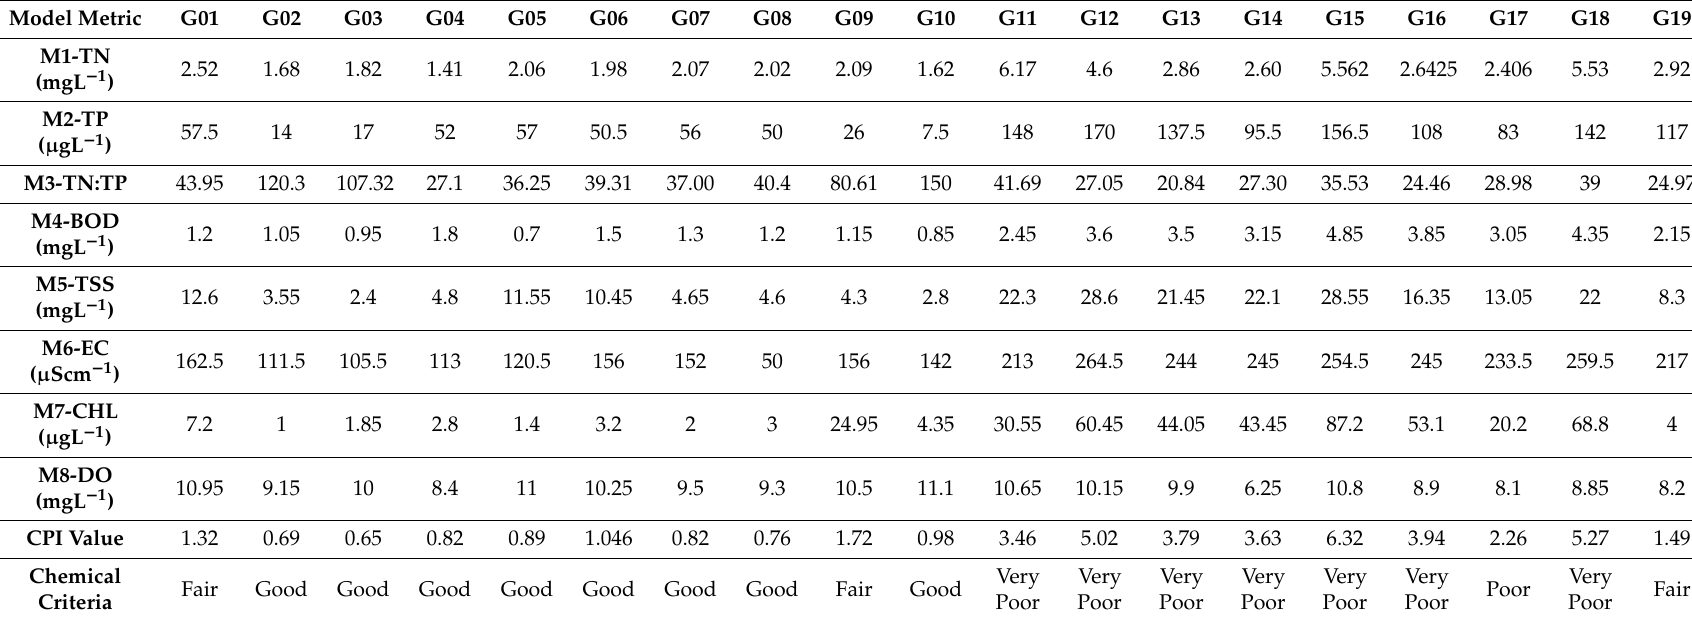
Table 1. Chemical health assessment using the chemical pollution index (CPI)